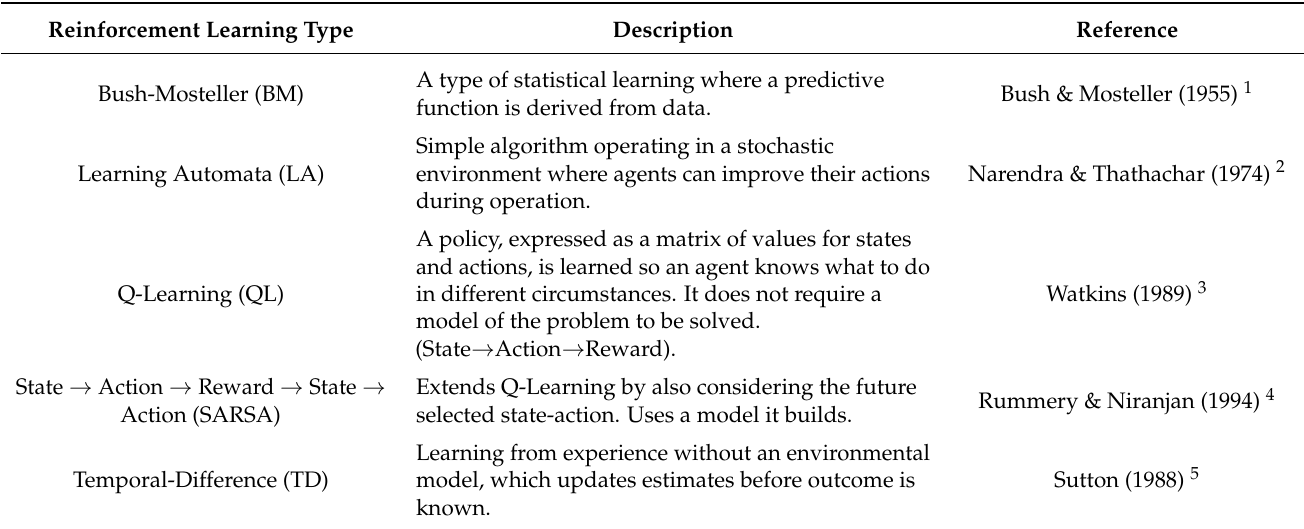
Table 1. Summary of RL types based on IAs, which are used in the modeling